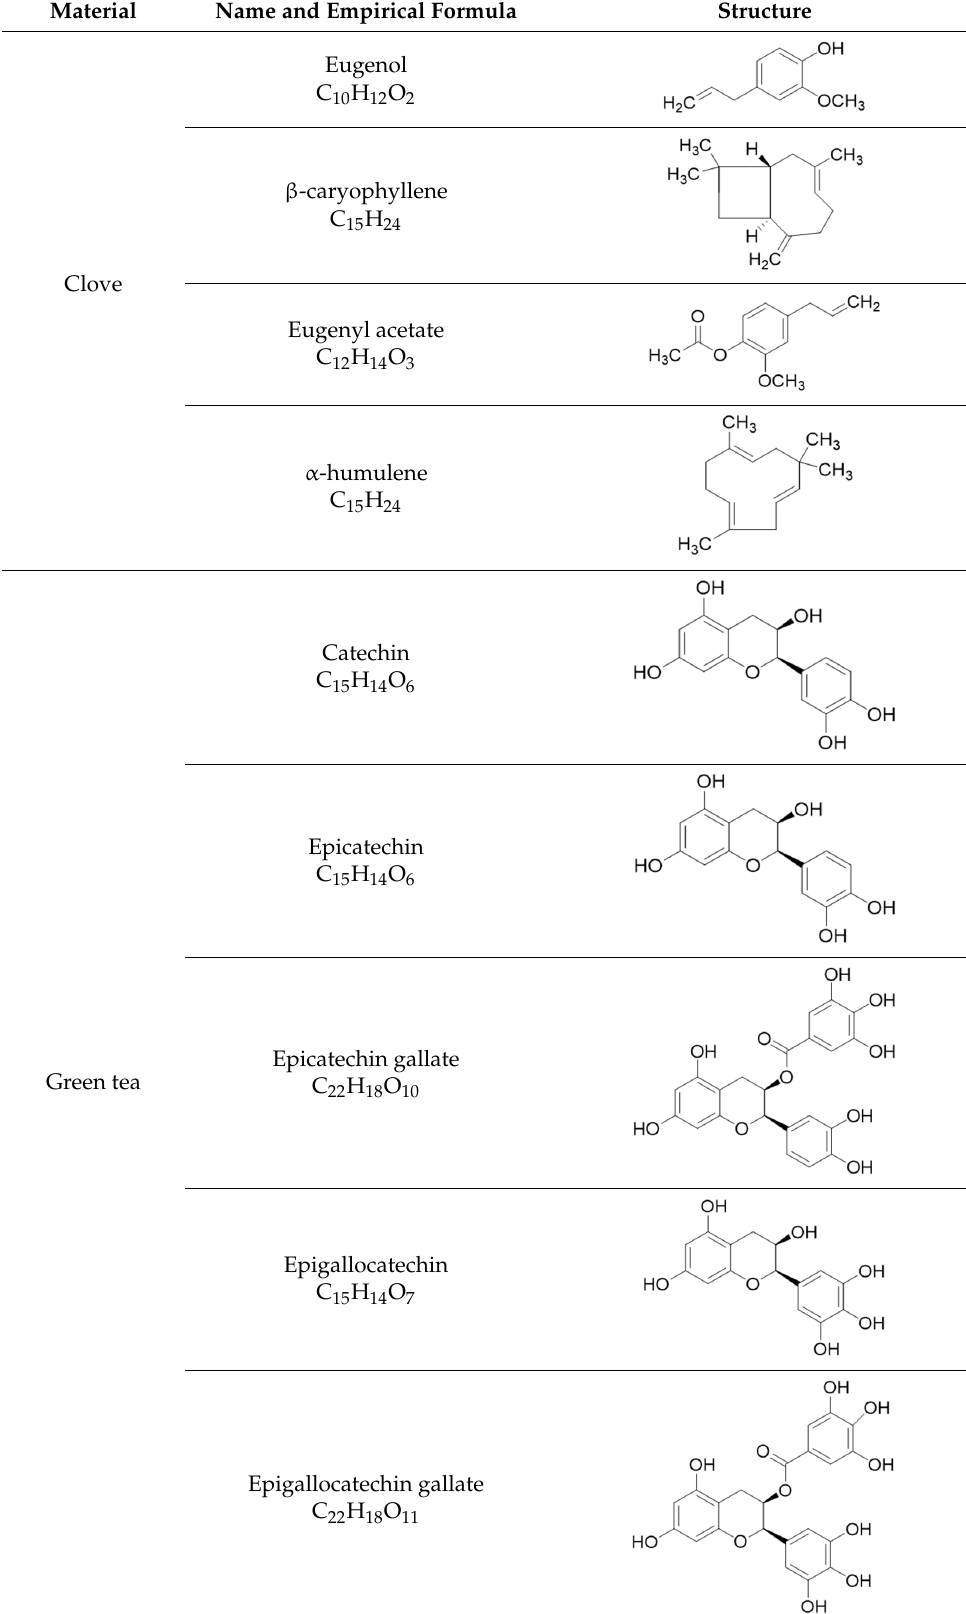
Material Name and Empirical Formula